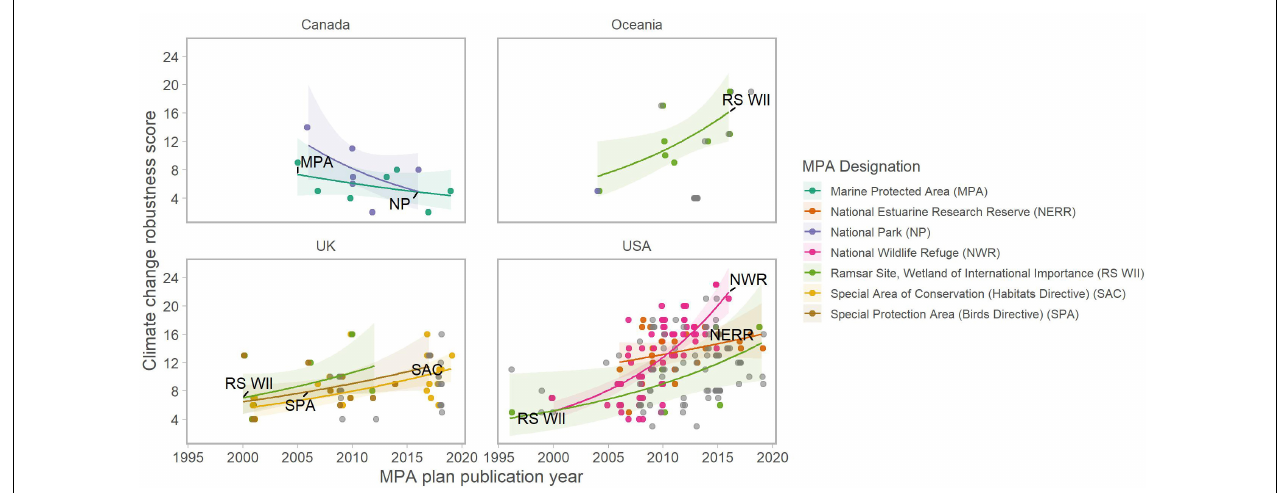
FIGURE 7 | Climate change robustness scores for the manually reviewed climate-considering MPA management plans by publication year. Trends in the scores of some of the most represented MPA designations in the dataset are shown using a generalized linear model fit with a negative binomial family and a log link. The lines are the mean predictions and the shaded areas are the 95% confidence intervals. Gray points represent all other MPA management plans in the